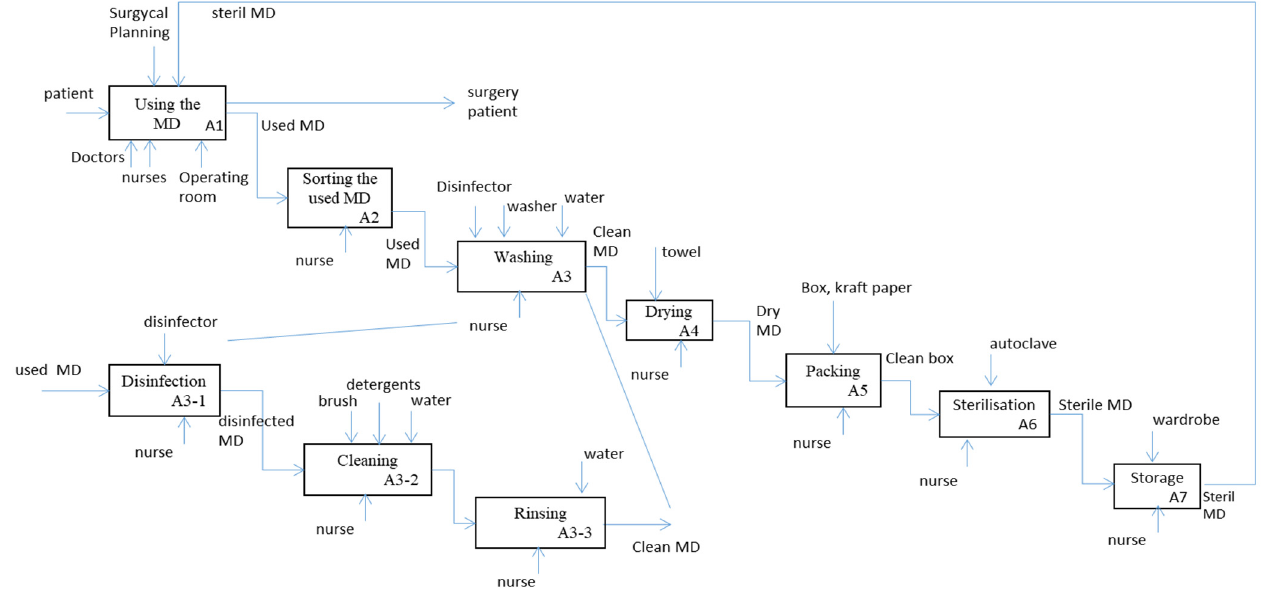
Figure 2. The sterilization process studied through an IDEF0